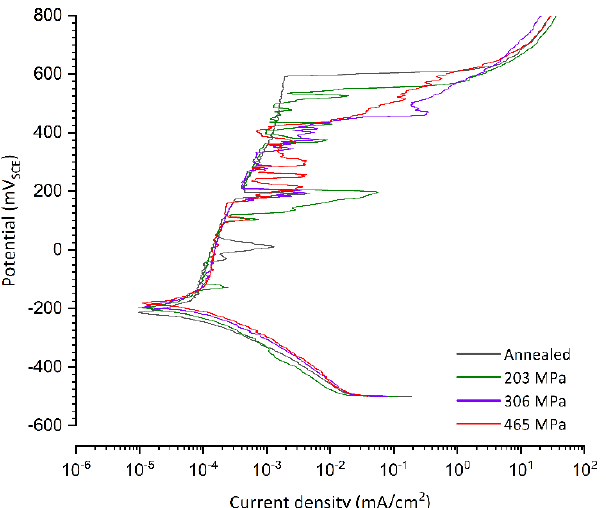
Figure 5. Potentiodynamic polarization measurements for specimens with different residual stress magnitude.